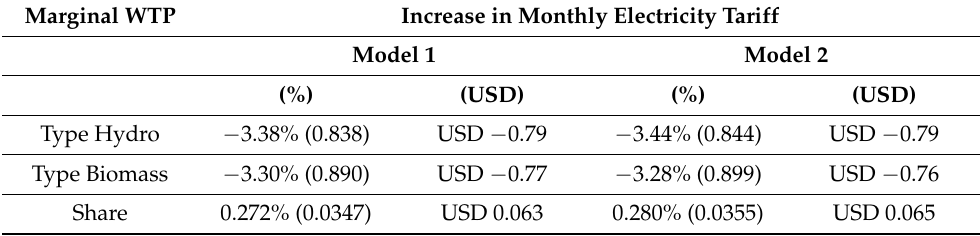
Table 5. Marginal willingness to pay (WTP) for renewable energy. Marginal WTP